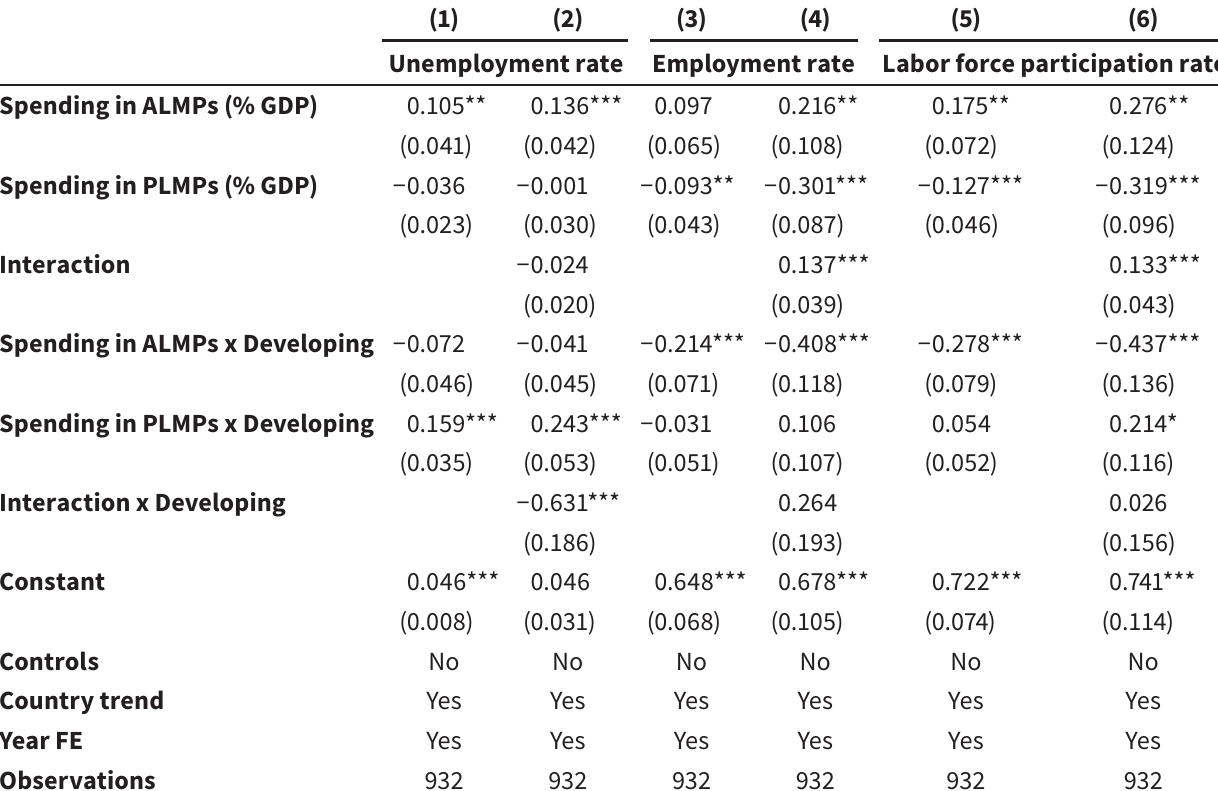
Table 8. Results for the heterogeneity analysis by development status estimated using